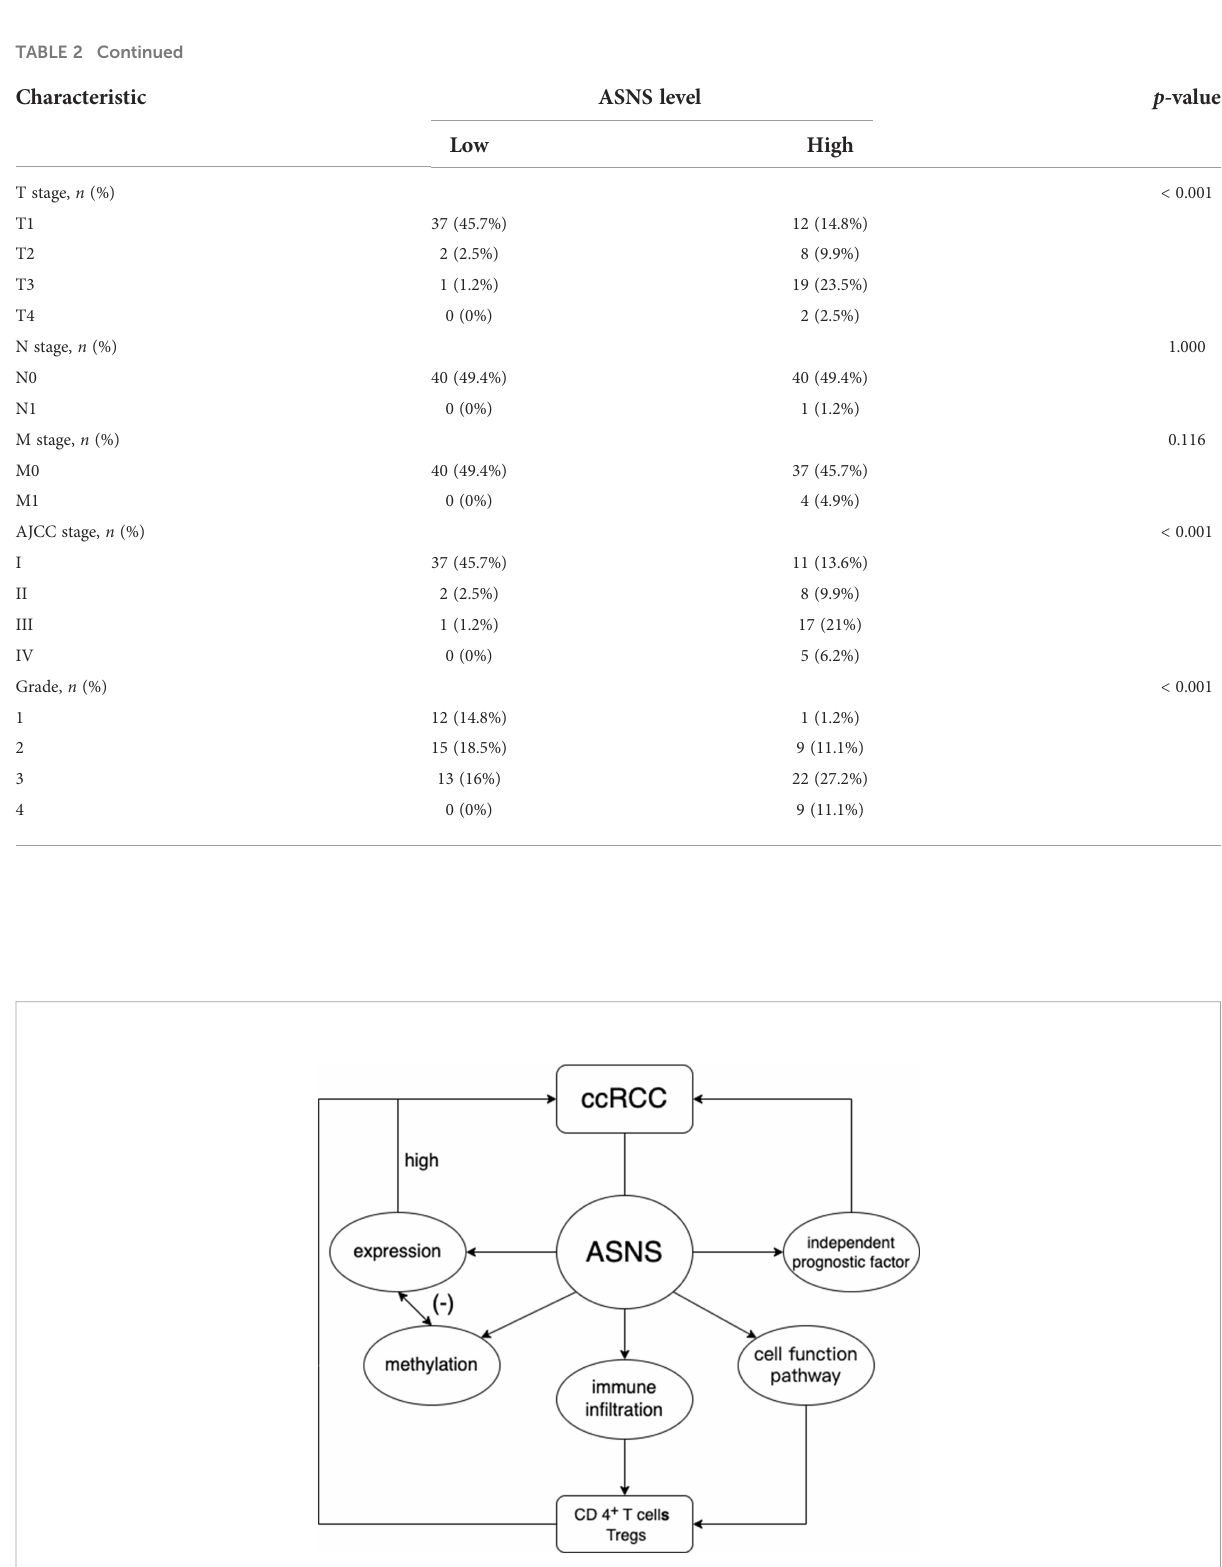
FIGURE 9 Study fl